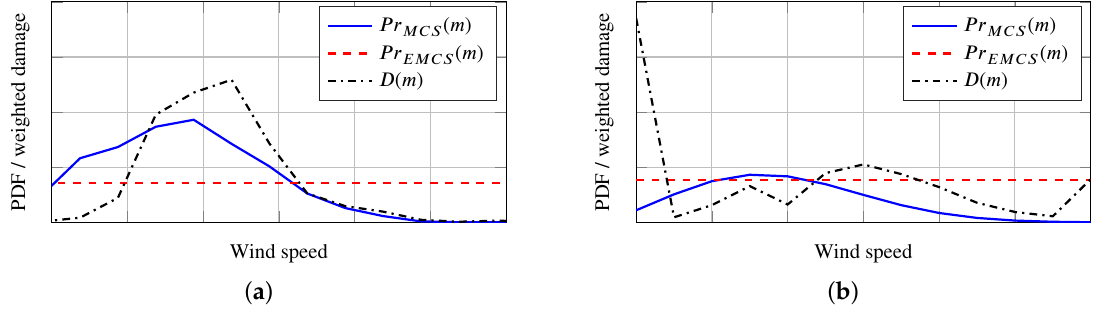
Figure 10. Qualitative comparison of the sampling distributions of EMCS ( Pr EMCS ( m ) ) and MCS ( Pr MCS ( m ) ) with the actual damage distribution ( D ( m ) ). ( a )Measurement data. ( b )Simulation data of Hübler et al. [18].